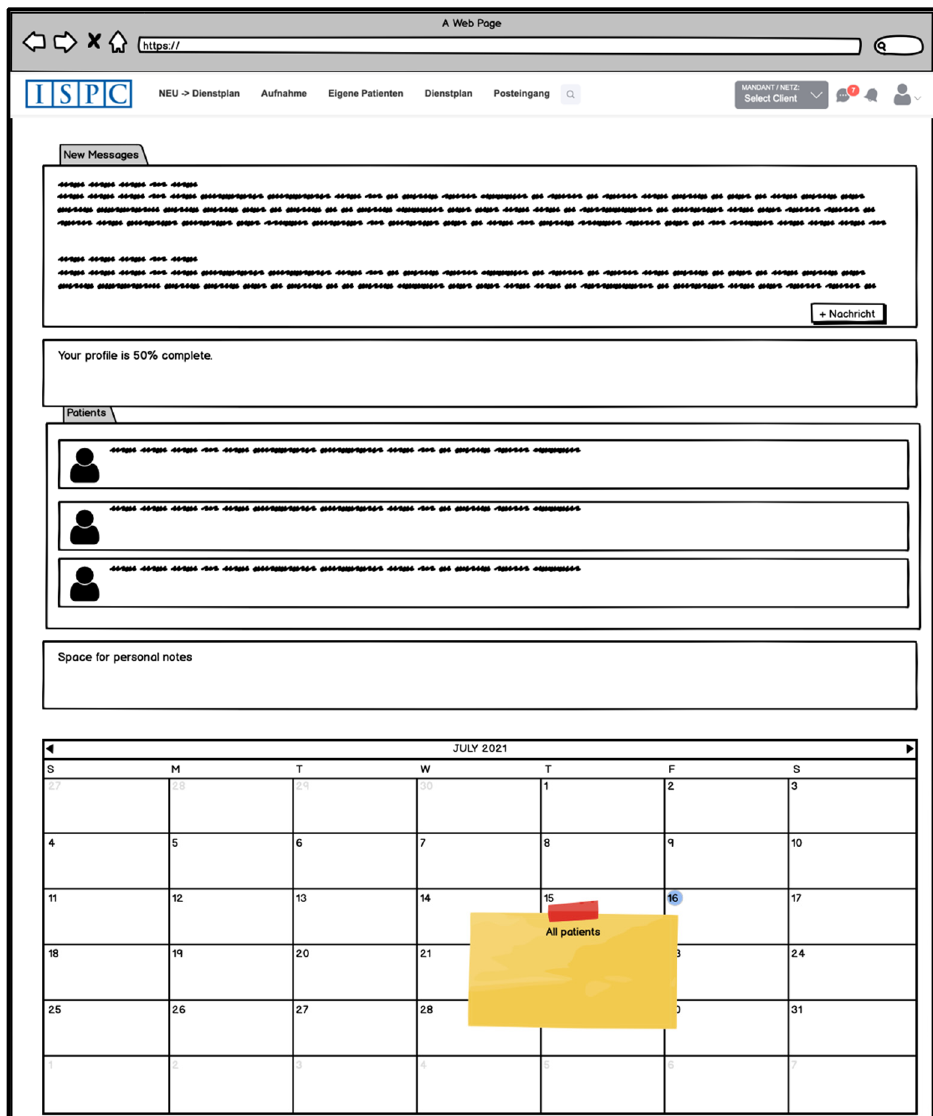
Figure 2. Idea for the superordinated starting page (part of the developed mock-up).